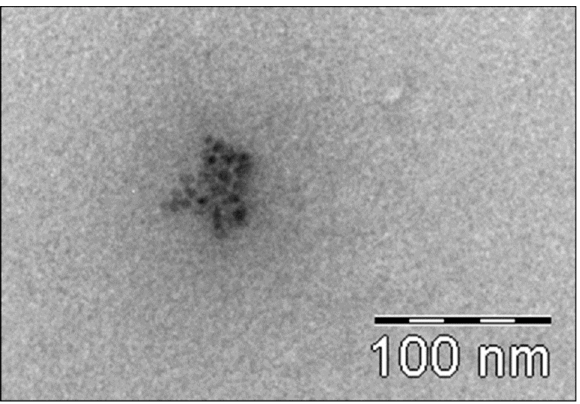
Figure 8. Transmission electron microscopy (TEM) micrograph of TiO 2 nanoparticles in the urine (with agglomeration of particles). Magnification bar = 100 nm.